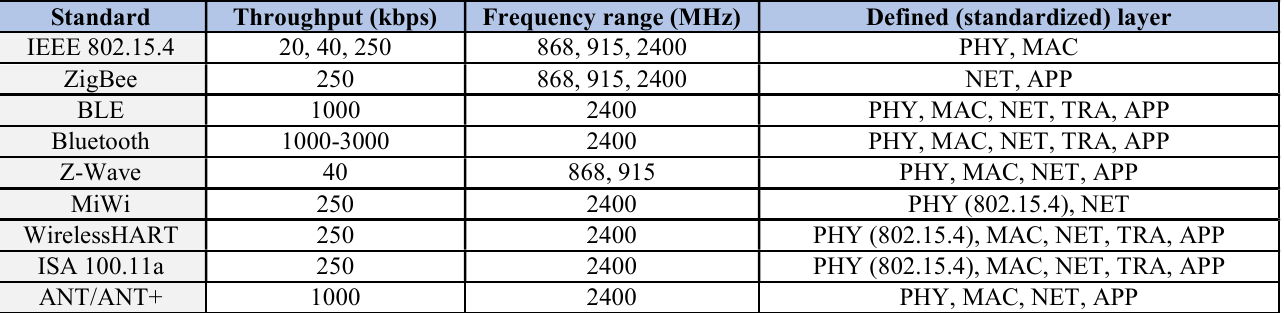
Table 2. An overview of WSNs towards